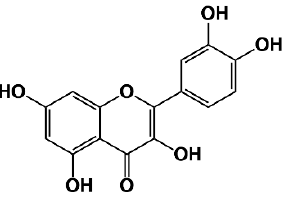
Figure 2. Quercetin, a typical flavonoid .